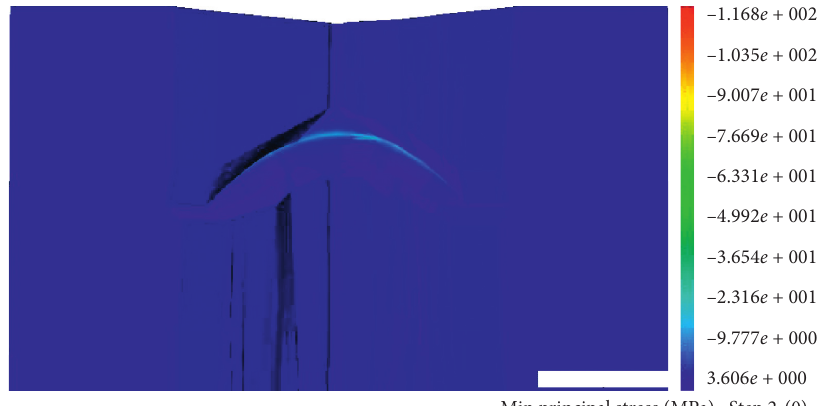
Figure 12: Minimum principal stress of foundation under working condition 4 (unit: MPa).